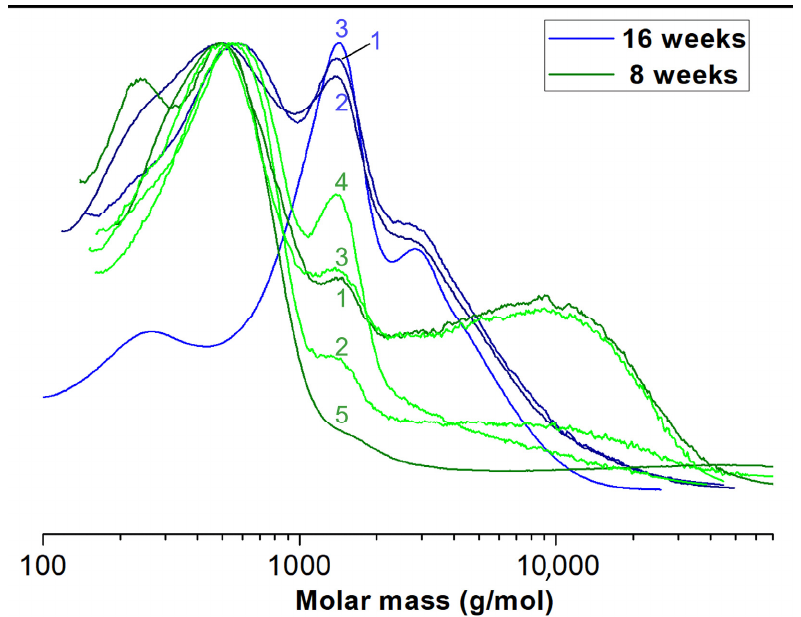
Figure 5. Exemplary molar mass distributions of extracted “PVP” membrane residue.